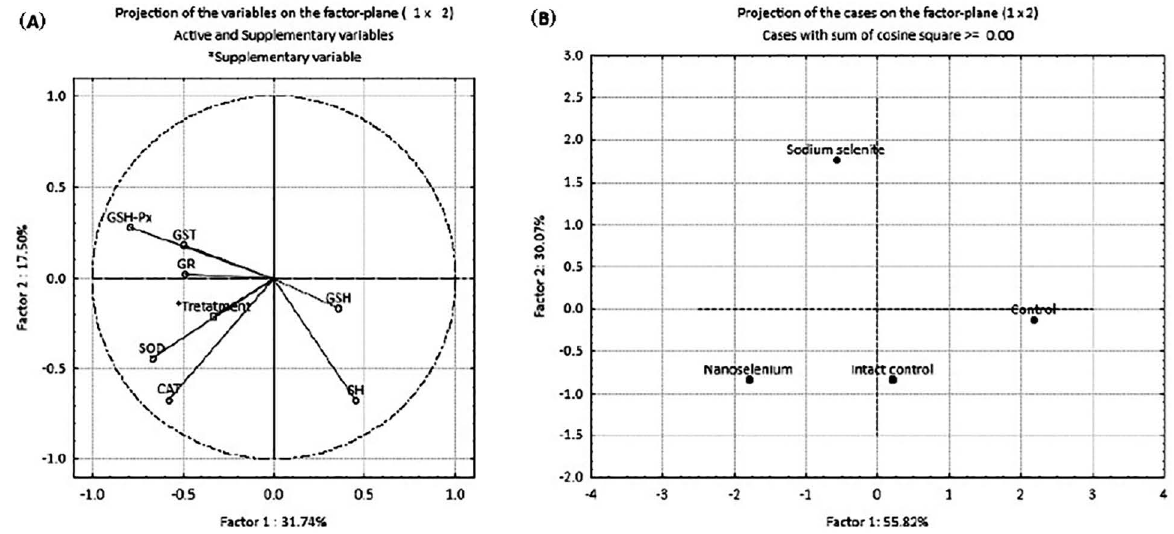
Figure 6. PCA of oxidative stress biomarkers in the placenta of pregnant Wistar albino rats in intact controls, controls, nanoselenium-treated animals and sodium selenite-treated animals. ( A ) —projection of the relative contribution of every antioxidant component; ( B ) —projection of groups based on antioxidant defense